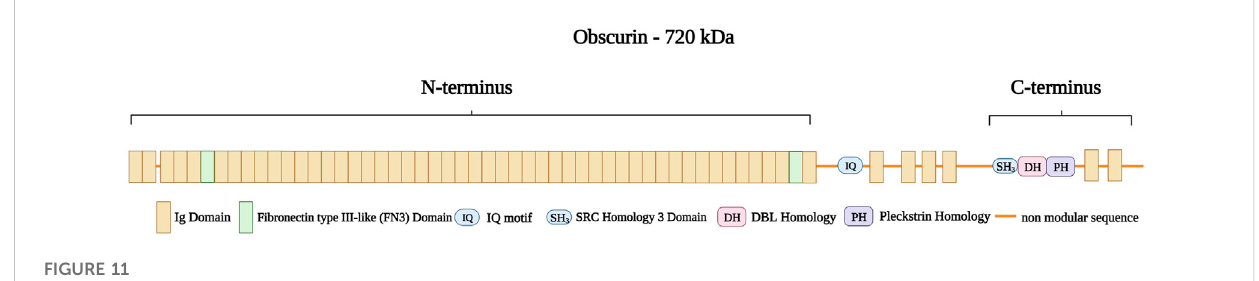
FIGURE 11 Schematic representation of obscurin A with the amino-terminus consisting of 49 Ig domains (brown) with two Fibronectin type III-like (FN3 domain, green) spanning the boundaries of the amino-terminus. This structure is followed by a non-modular sequence intersected by an IQ motif and four Ig domains. The caboxy-terminus consists of a SRC Homology three Domain (SH3), a DBL Homology domain (DH), and a Pleckstrin Homology domain (PH) followed by two Ig domains. Created with